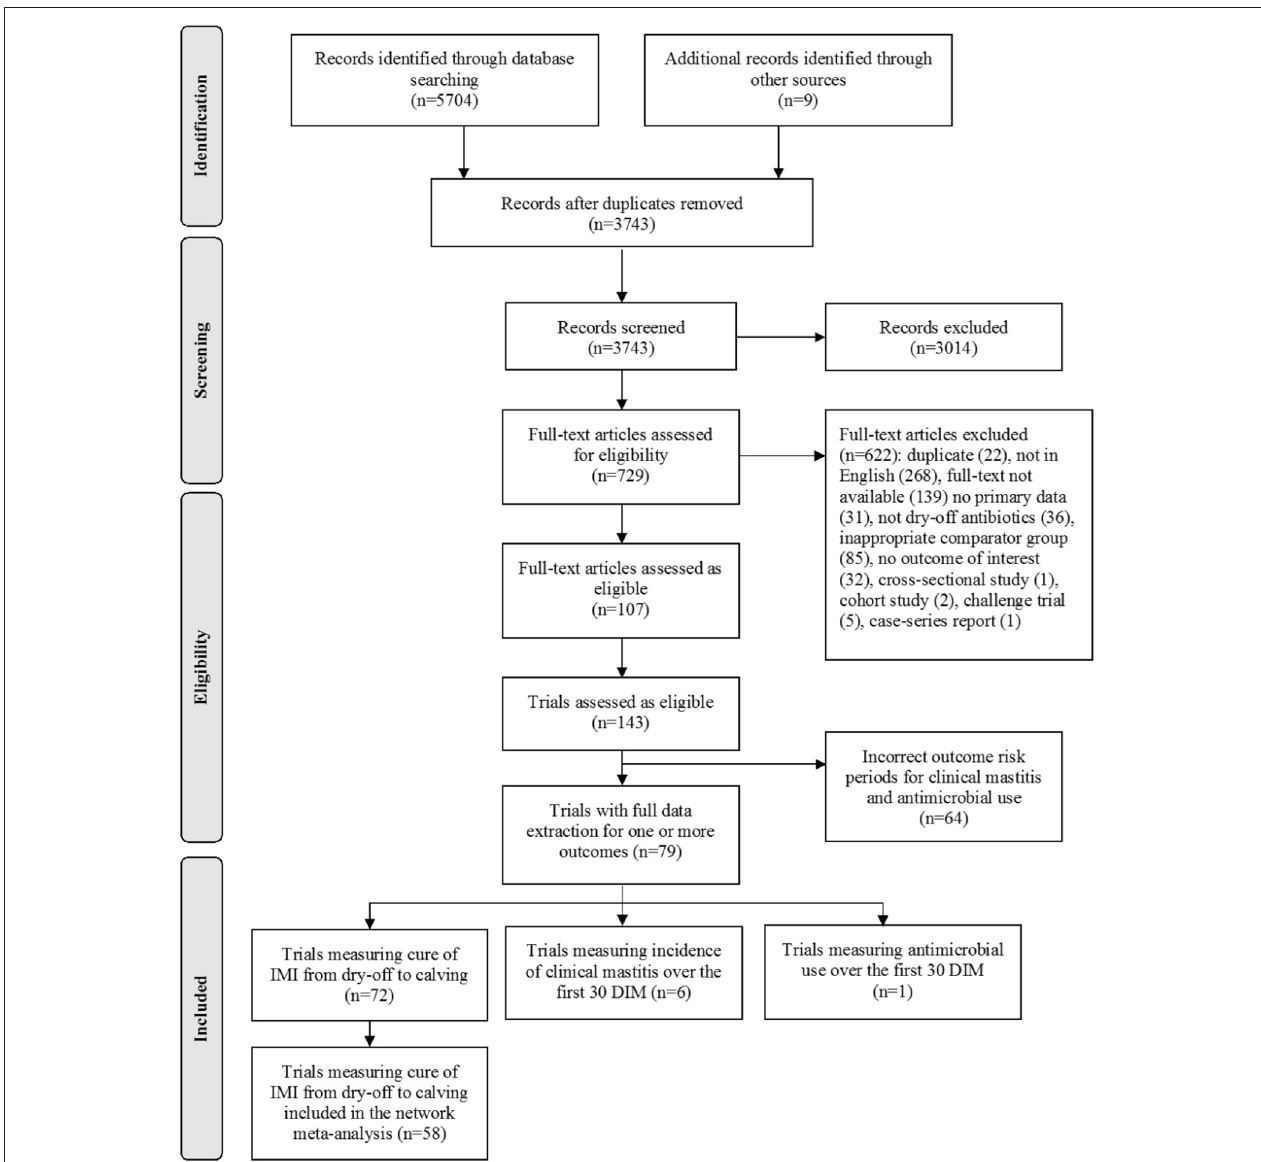
FIGURE 1 | Preferred Reporting Items for Systematic Reviews and Meta-analyses (PRISMA) flow diagram of the included studies and trials for the systematic review of dry-off antimicrobials to cure existing intramammary infections (IMI) in dairy cattle (Moher et al., 2009). The search, conducted by the researchers at the University of York, UK provided an update to a search used to identify the articles for a previous systematic review and network meta-analysis (Winder et al.,